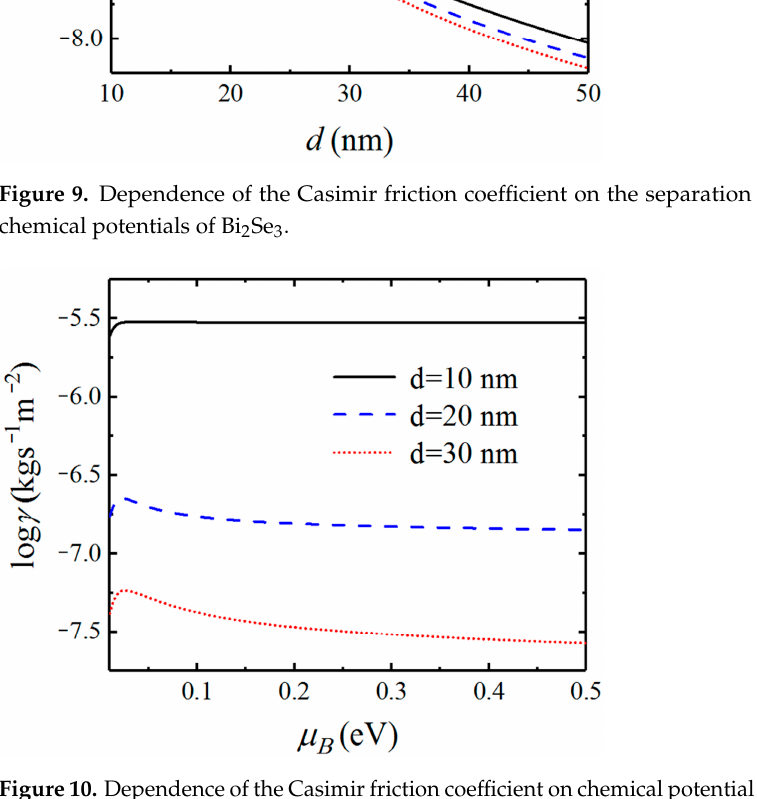
Figure 9. Dependence of the Casimir friction coefficient on the separation distances for different chemical potentials of Bi 2 Se 3 .